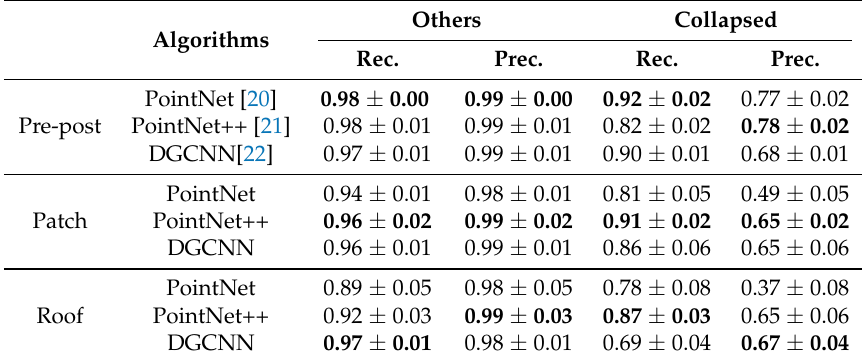
Table 6. Emergency mapping results. The best performances of each category and data availability are highlighted.